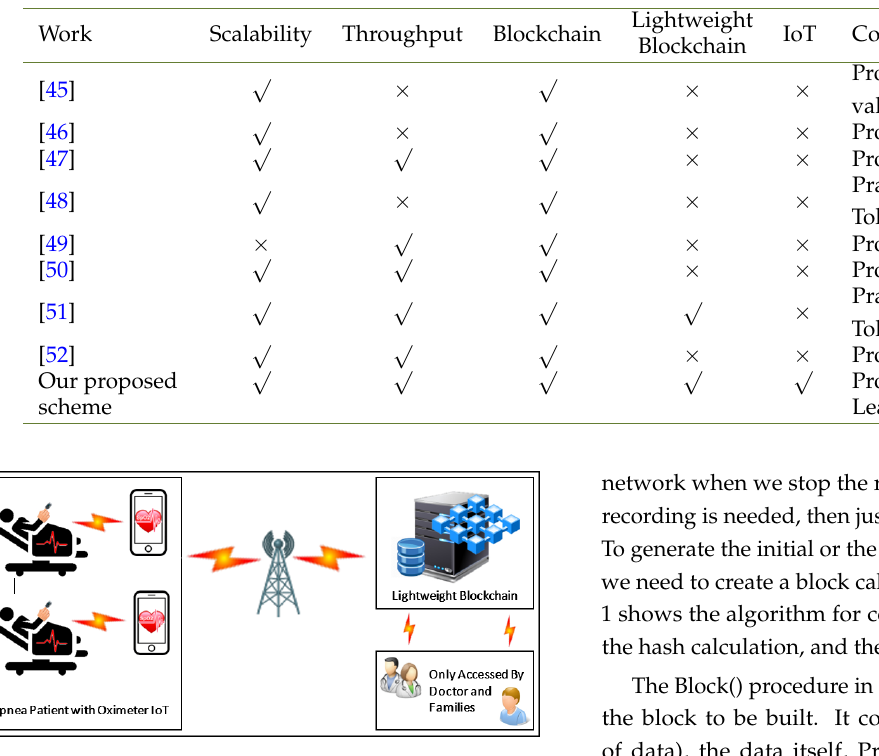
Fig. 3. The Proposed Design